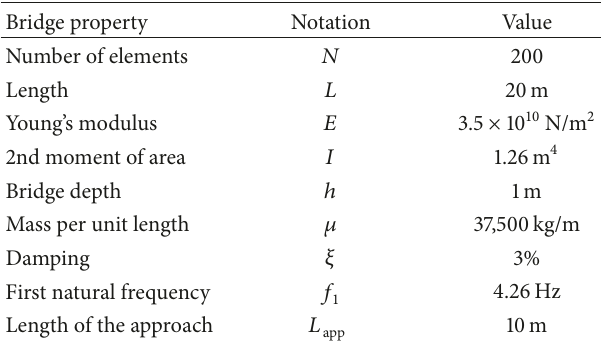
Table 2: Properties of the